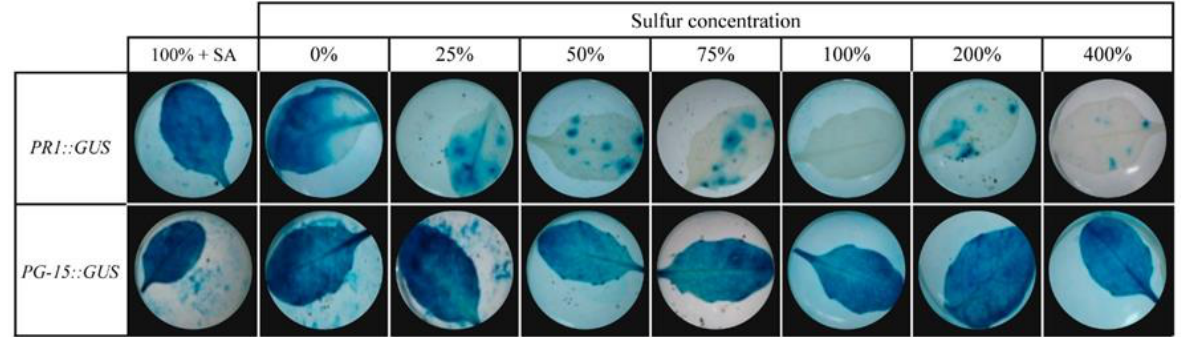
Figure 4. PR1 expression induced by application of different sulfur concentrations on five-week-old PR1::GUS plants. 100% corresponds to ½ MS standard (control) sulfur concentration. PG15::GUS line and SA application were used as positive controls.